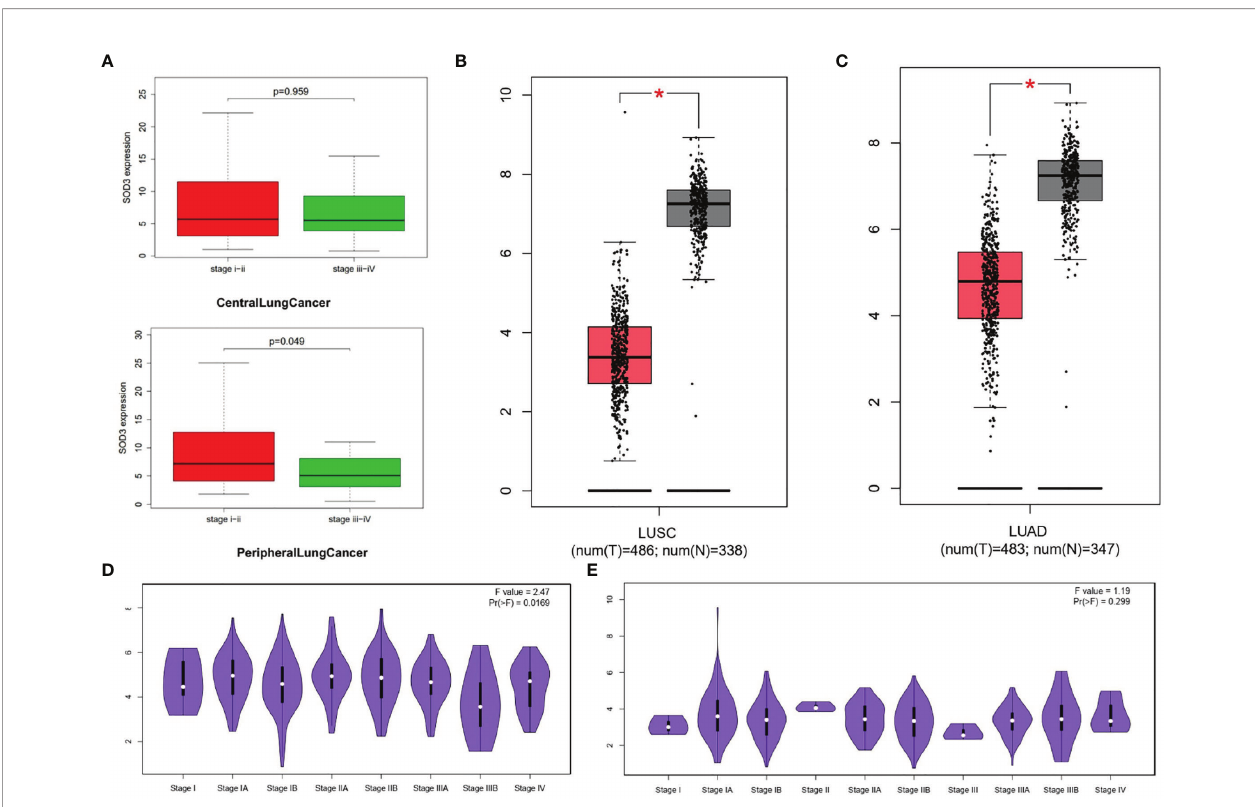
FIGURE 3 | (A) The expression levels of SOD3 in different stages of CentralLungCancer and PeripheralLungCancer respectively. (B) SOD3 expression of normal and tumor tissues in LUSC. (C) SOD3 expression of normal and tumor tissues in LUAD. (D) SOD3 expression of different stages in LUAD. (E) SOD3 expression of different stages in LUSC. *p <